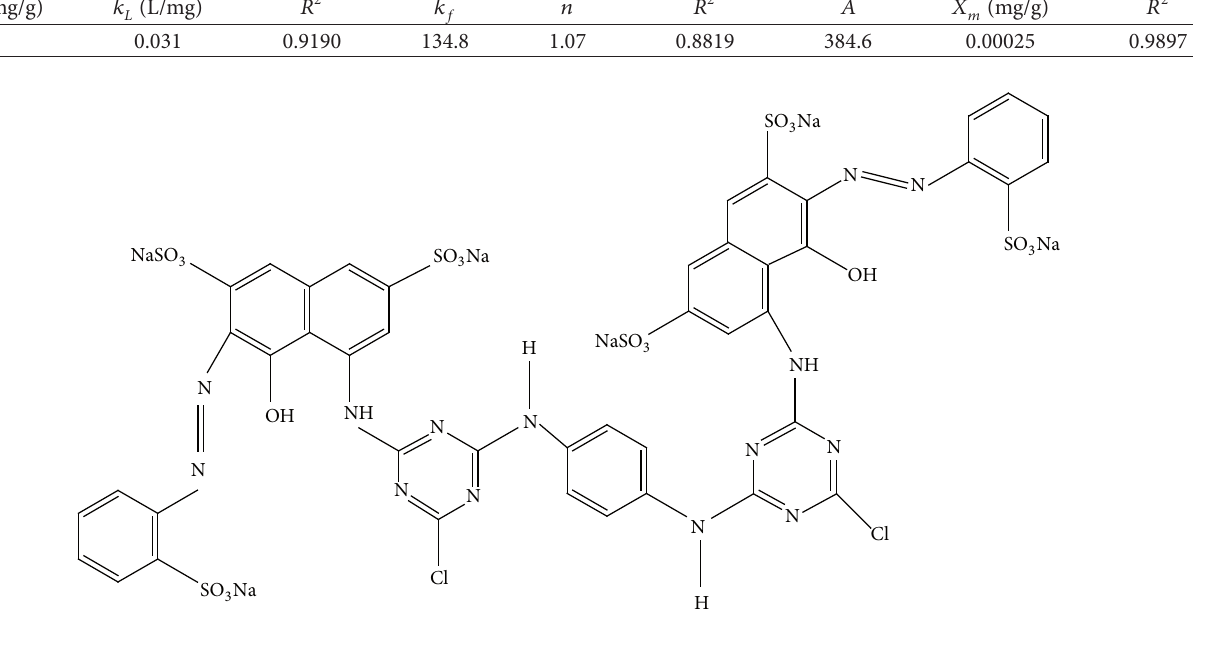
F 1: e chemical structure of the Reactive Red-120.